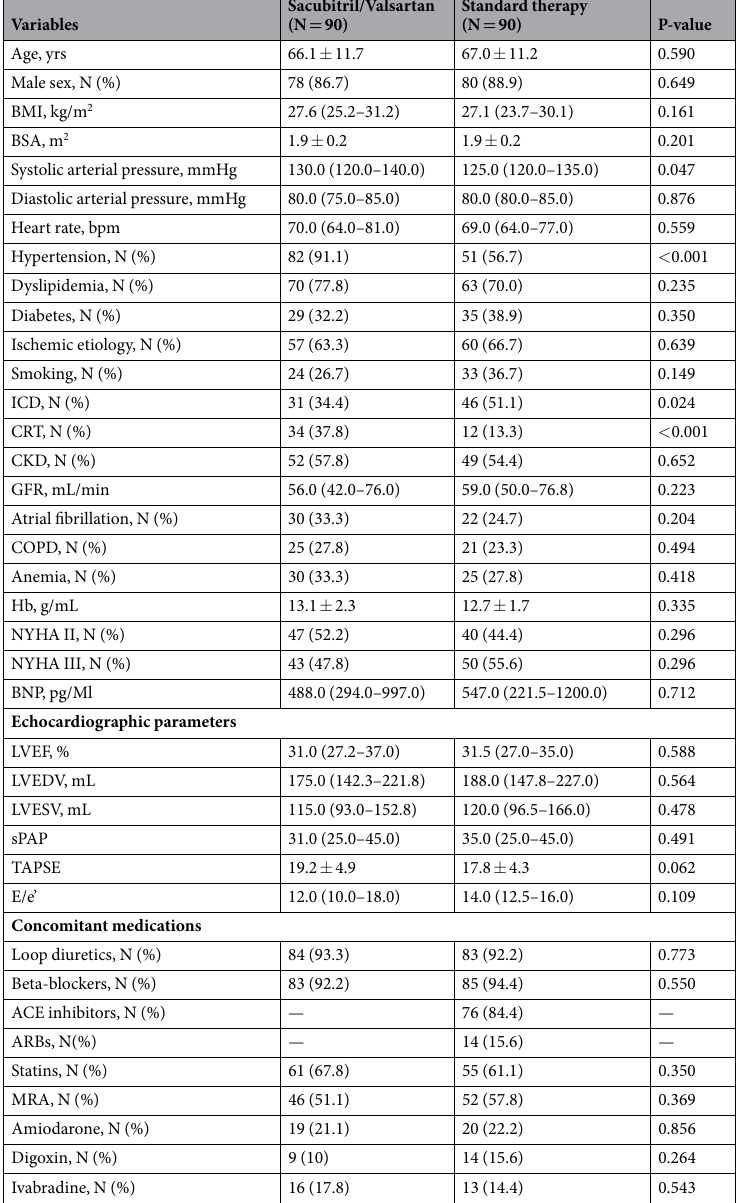
Table 1. Baseline characteristics of Sacubitril/Valsartan and standard therapy groups (N = 180). Continuous normally distributed variables are expressed as mean ± SD. Categorical variables are n (%).